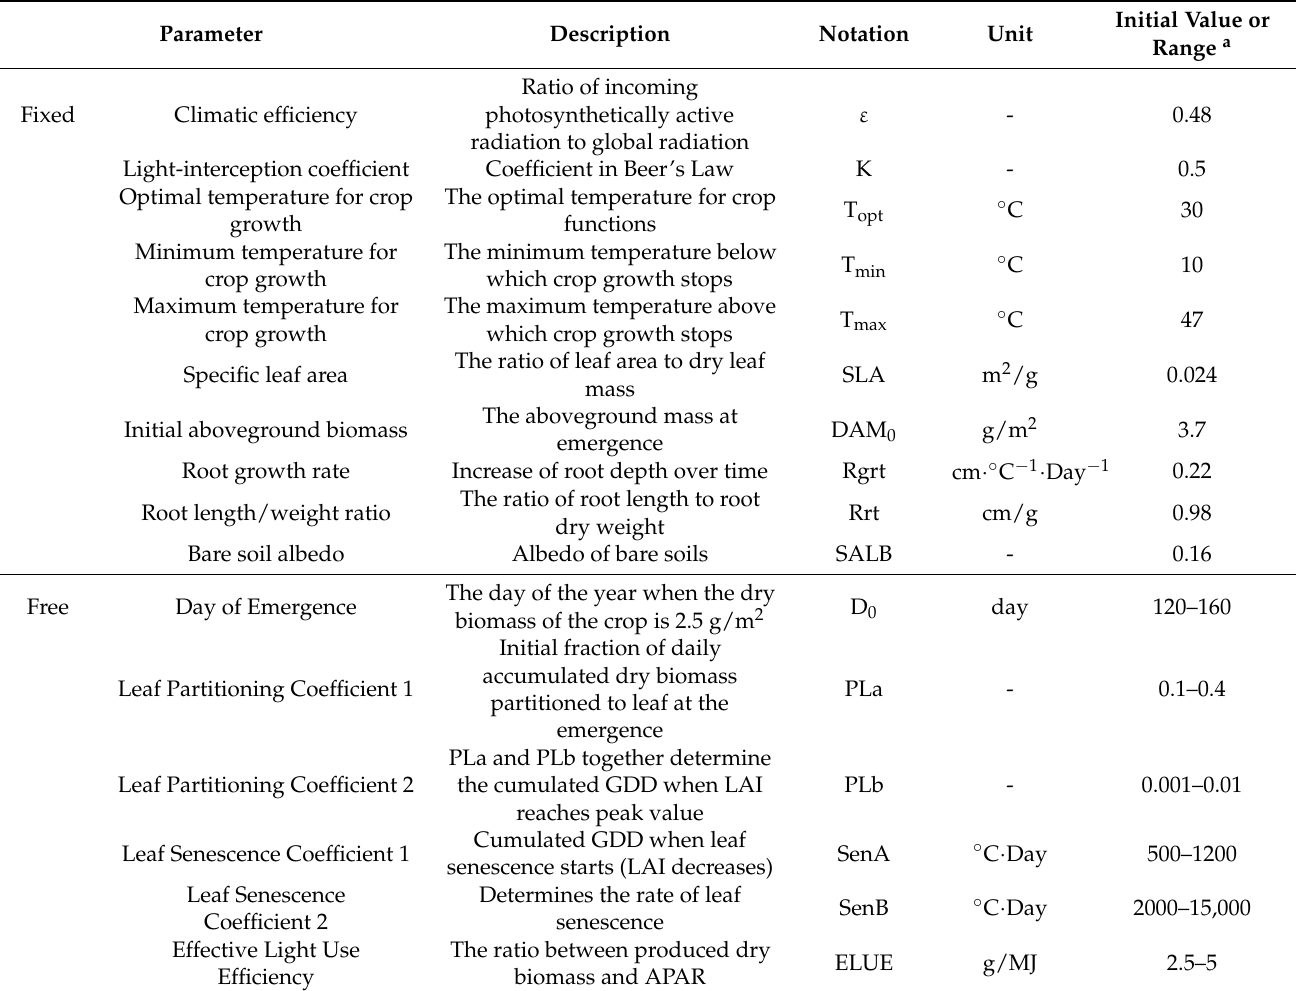
Table 3. List of parameters and description for the modified simple algorithm for yield (SAFYswc)